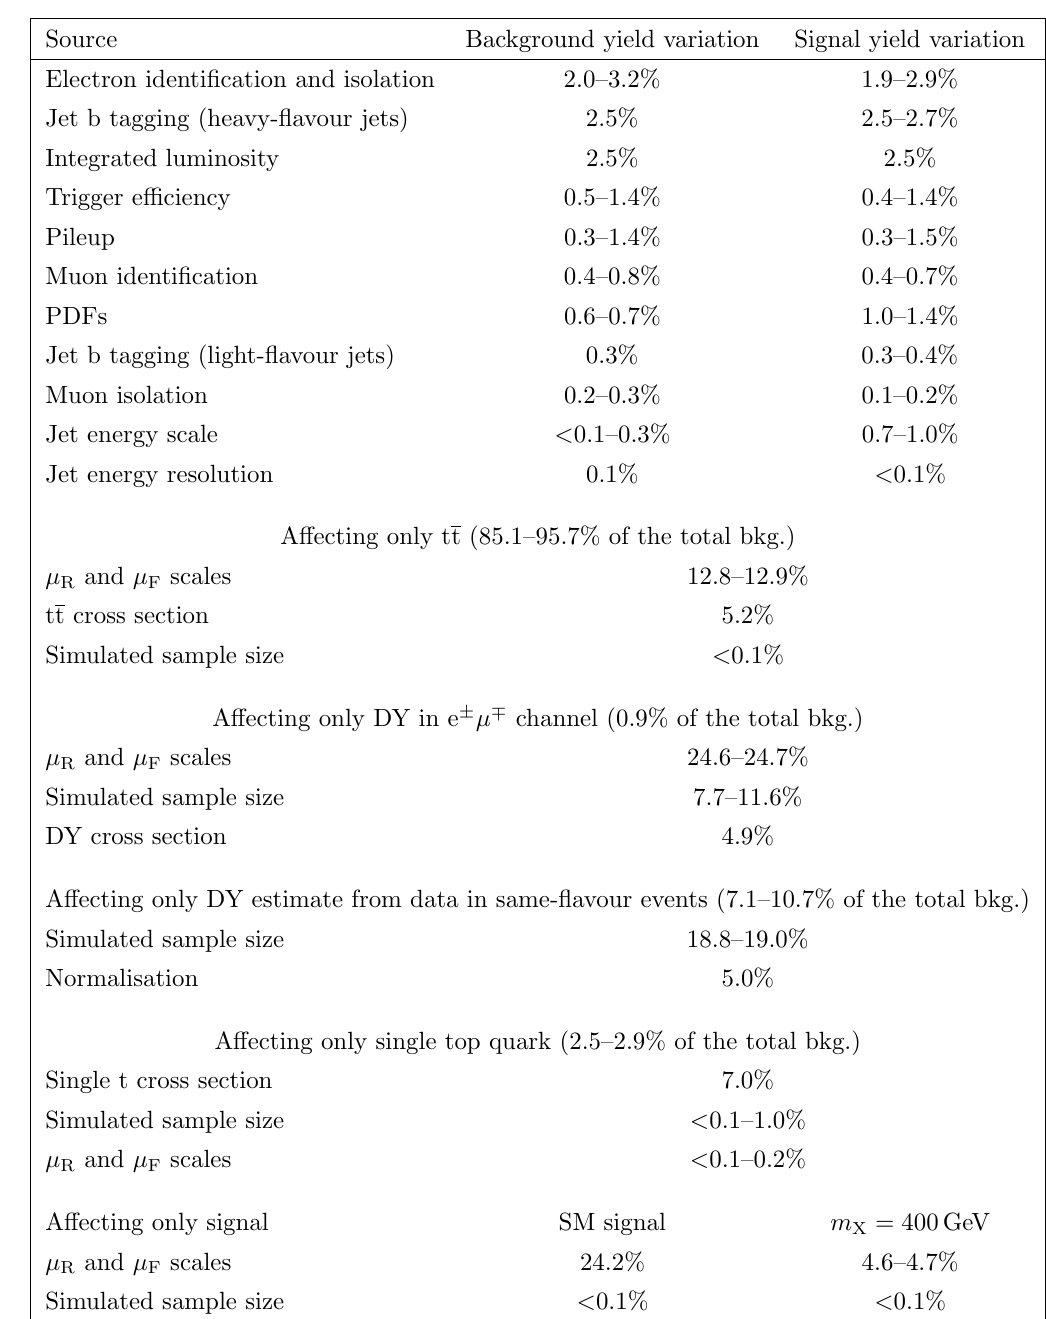
Table 1 . Summary of the systematic uncertainties and their impact on total background yields and on the SM and m X = 400 GeV signal hypotheses in the signal region.